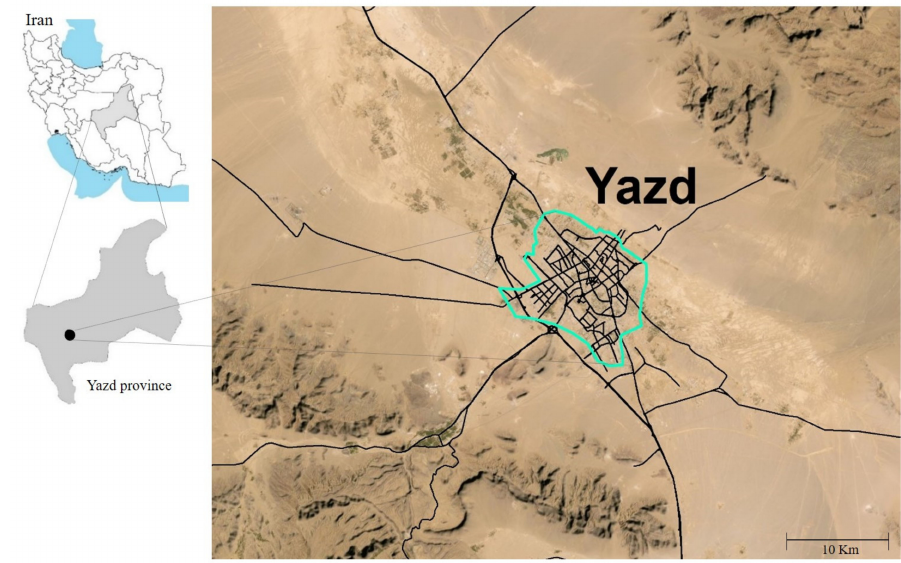
Figure 1. The main picture in the center shows the location of the study area in central Iran, adjacent to the Kuhe-Karanaq mountain in the northeast and Shir-Kuh mountain in the southwest of the city. The dark lines illustrate the road network of the city with its surrounding